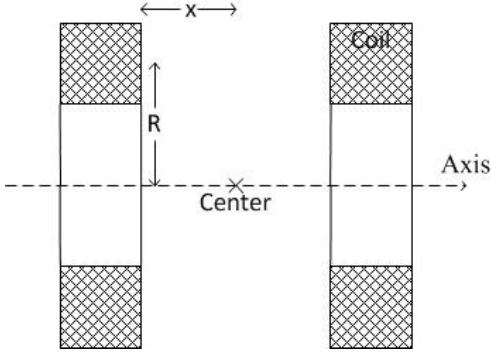
Figure 2. Geometric arrangement of the Helmholtz